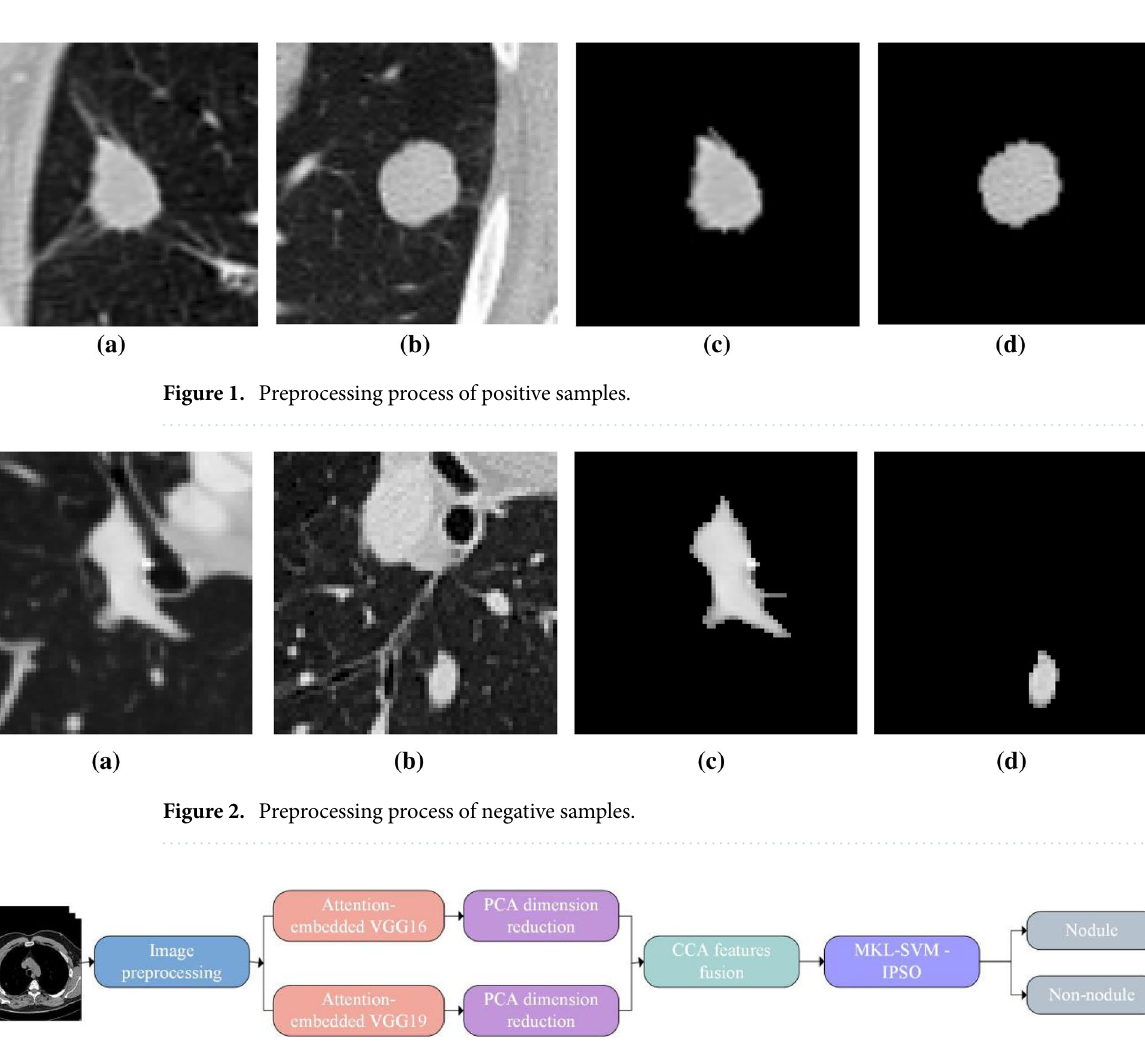
Figure 3. The block diagram of the proposed lung CAD